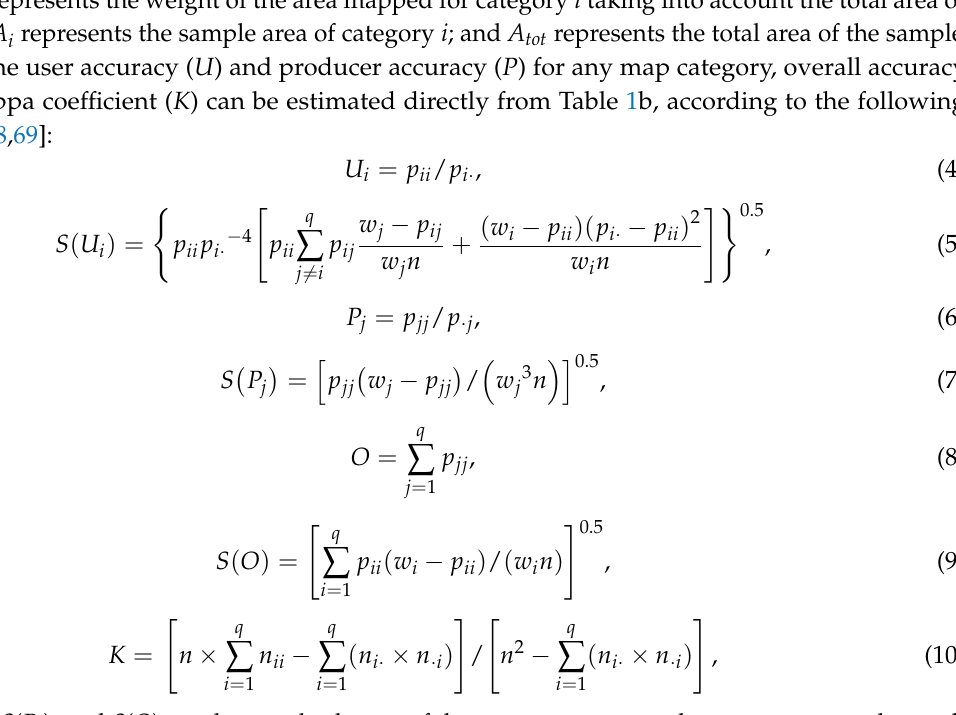
Map categories are the rows and validation categories are the columns.